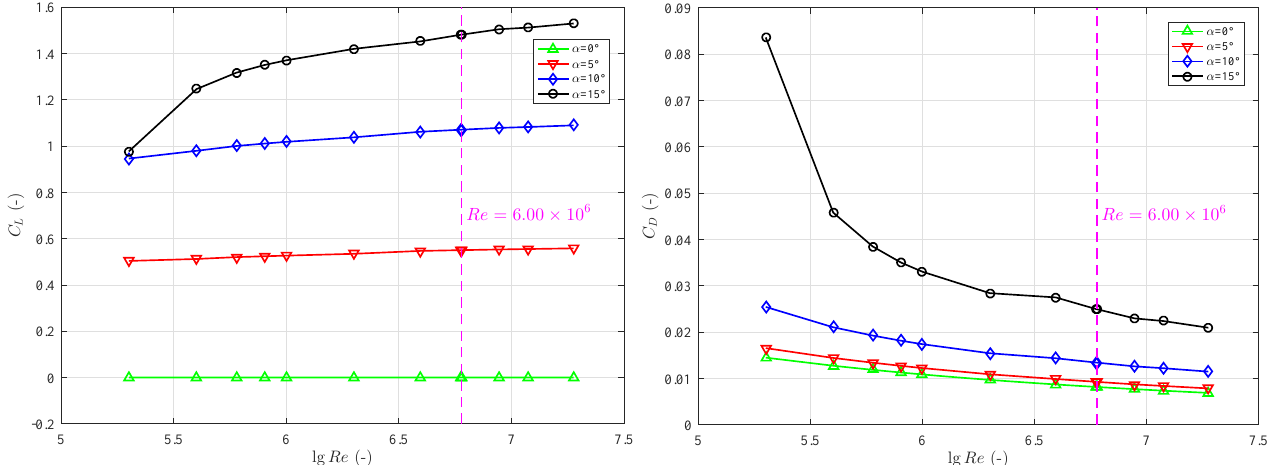
Figure 10. Impacts of Re on lift and drag coefficients.